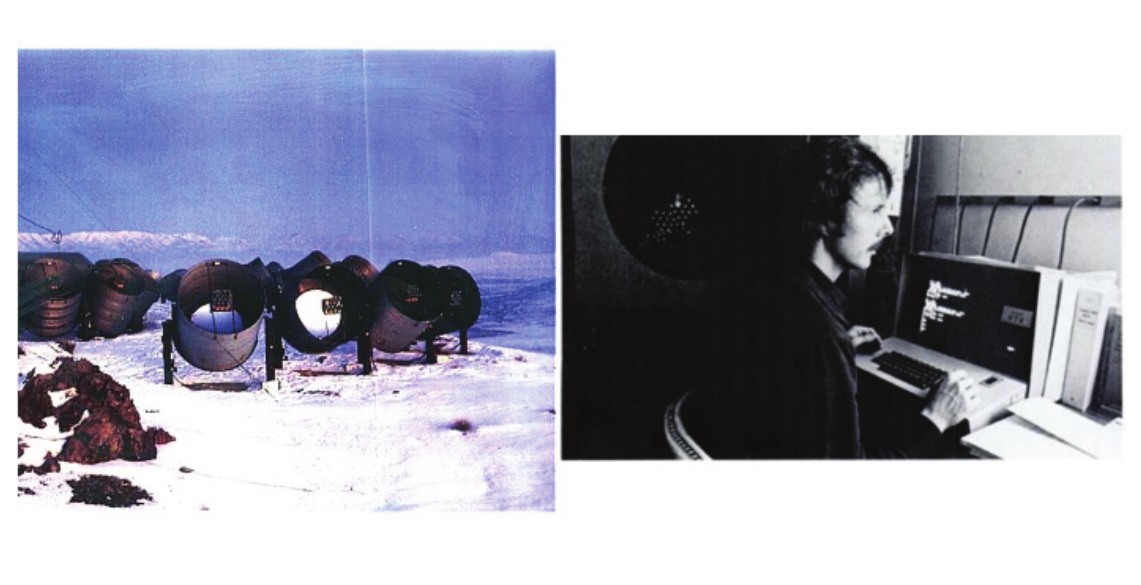
Figure 4. The Utah Fly’s Eye detector (L). G. Cassiday at the control terminal. The display behind him was a unique planetarium dome with LED’s representing each tube’s pointing direction. Events were displayed as they came in with the relative timing slowed down so the human eye could see the track development.